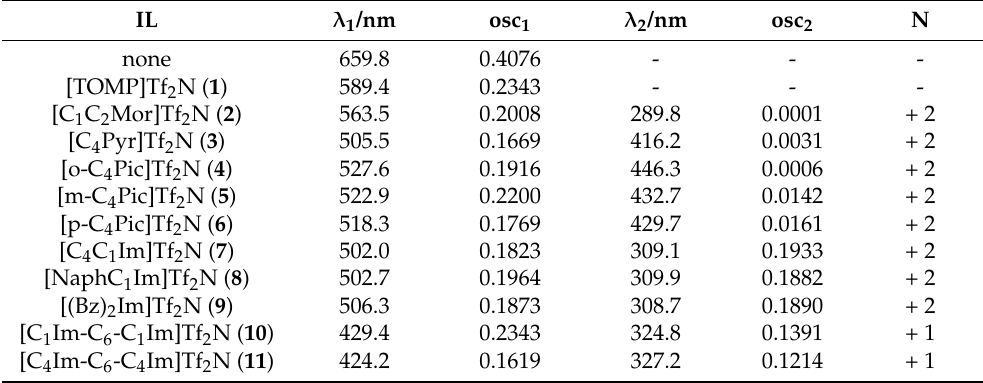
Table 2. Data on TDDFT excitations. Transition one was the usual HOMO to the standard charge-transfer effect of the solvatochromic probe. Transition two was a transition between HOMO and a mix of virtual orbitals where the main component was the LUMO + N